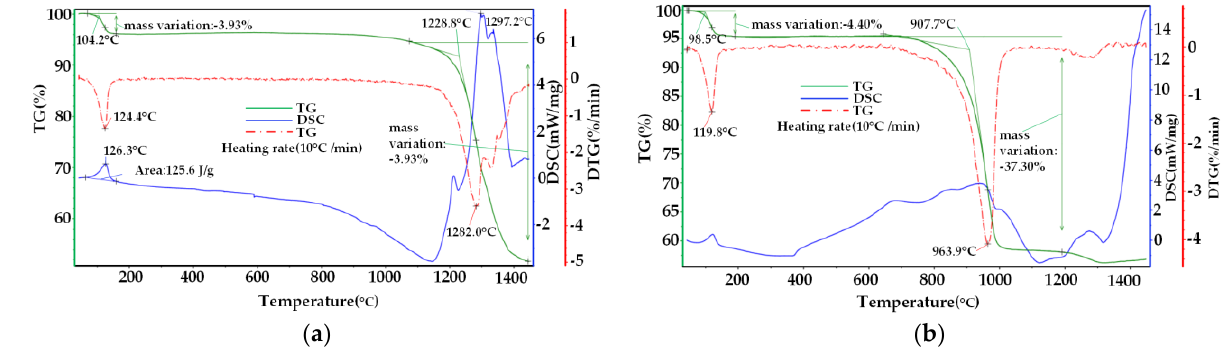
Figure 5. Thermal analysis of phosphogypsum decomposition: ( a ) Phosphogypsum decomposes itself; ( b ) adding 4% carbon powder while introducing CO atmosphere.